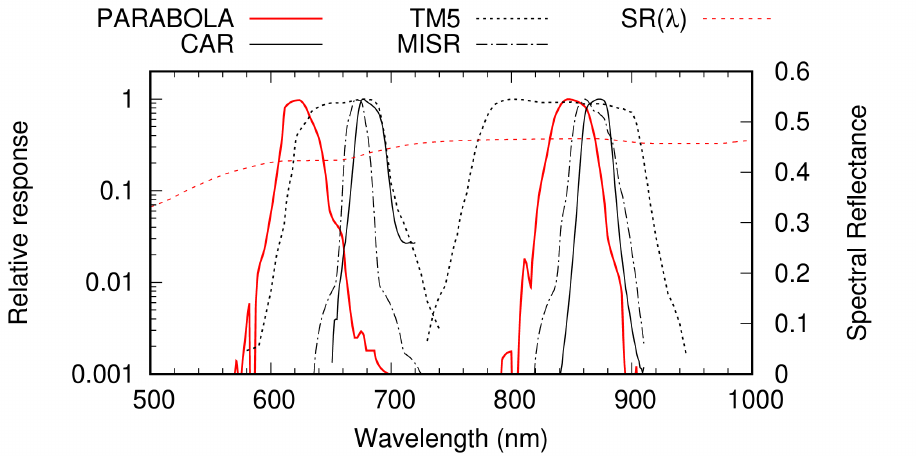
Figure 1. Relative spectral responses of PARABOLA, CAR, Landsat 5-TM and MISR in the red and NIR bands. A typical hyperspectral reflectance curve SR( λ ) for RRV is adapted from Figure 4 of [30], and was acquired on 2003-08-19 with a spectroradiometer. The central wavelengths are reported